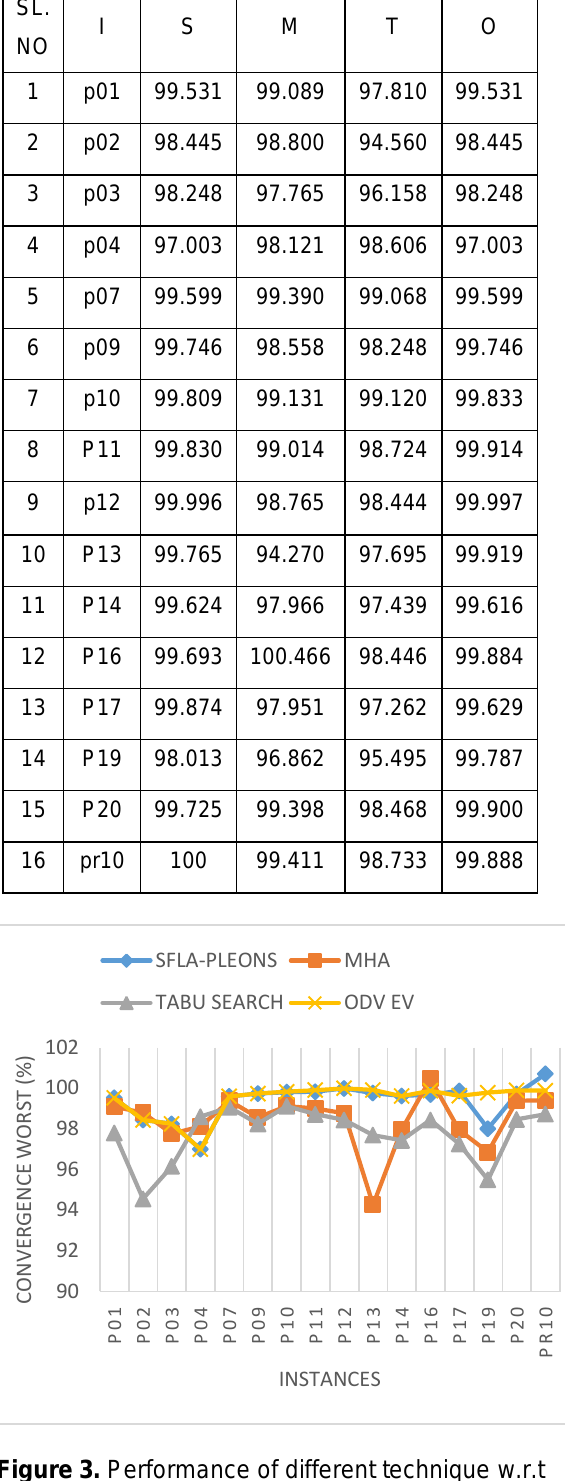
Figure 4. Performance of different techniques